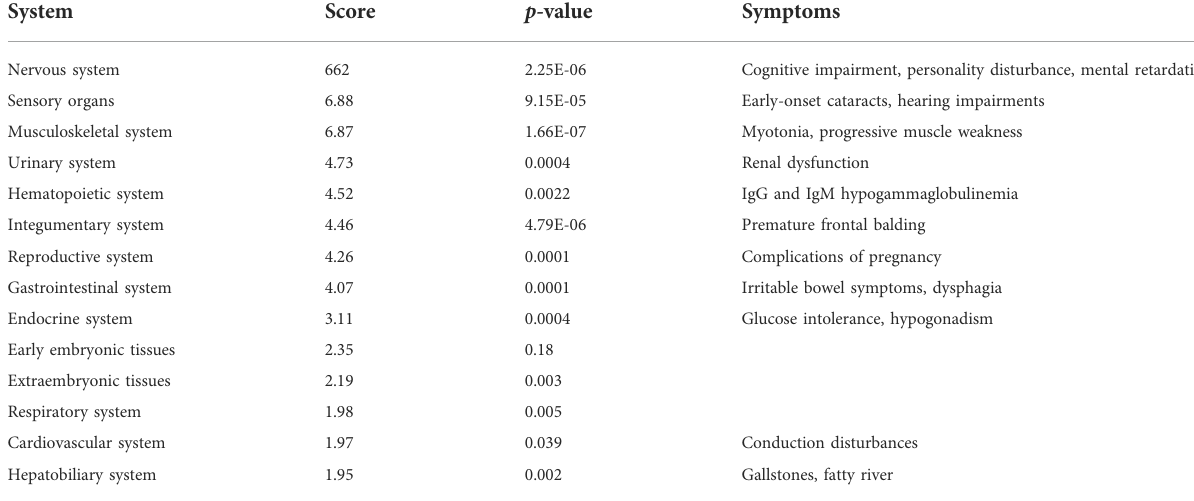
TABLE 2 Enrichment of transcription factors bearing 6CTG/CAG repeats in body systems. TFs with CTG/CAG repeats are signi fi cantly expressed in tissues presenting symptoms associated with DM1. System scores and p -values following FDR are presented. System